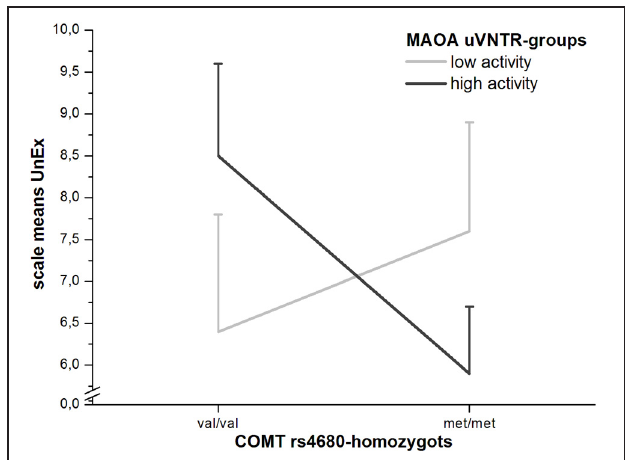
FIGURE 2 | Moderation of COMT Val 158 Met-effects on UnEx by MAOA-functionality (with standard errors of the means).